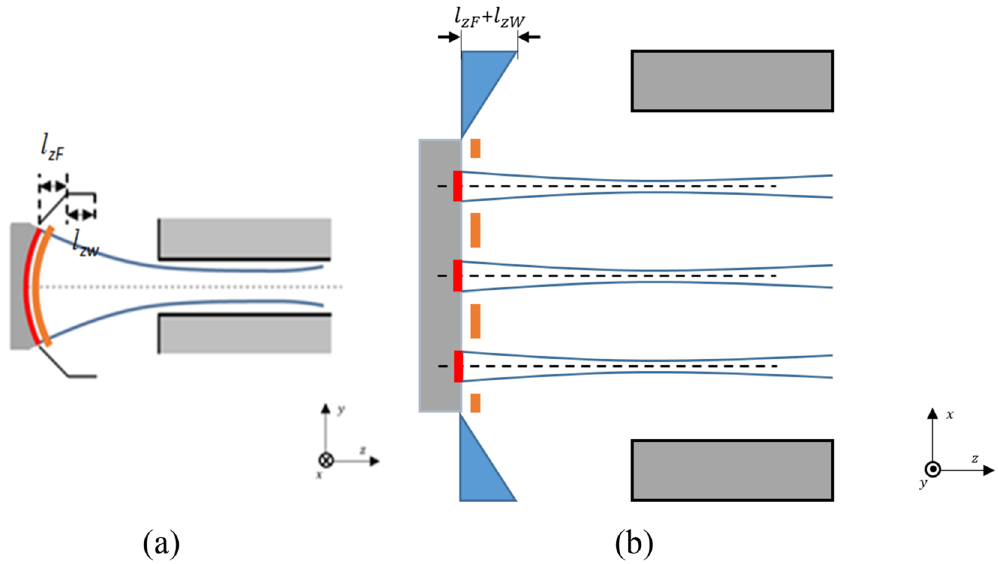
Figure 2. Schematic of the novel planar three-beam electron gun in both two transverse directions. ( a ) Front view. ( b ) Top view.